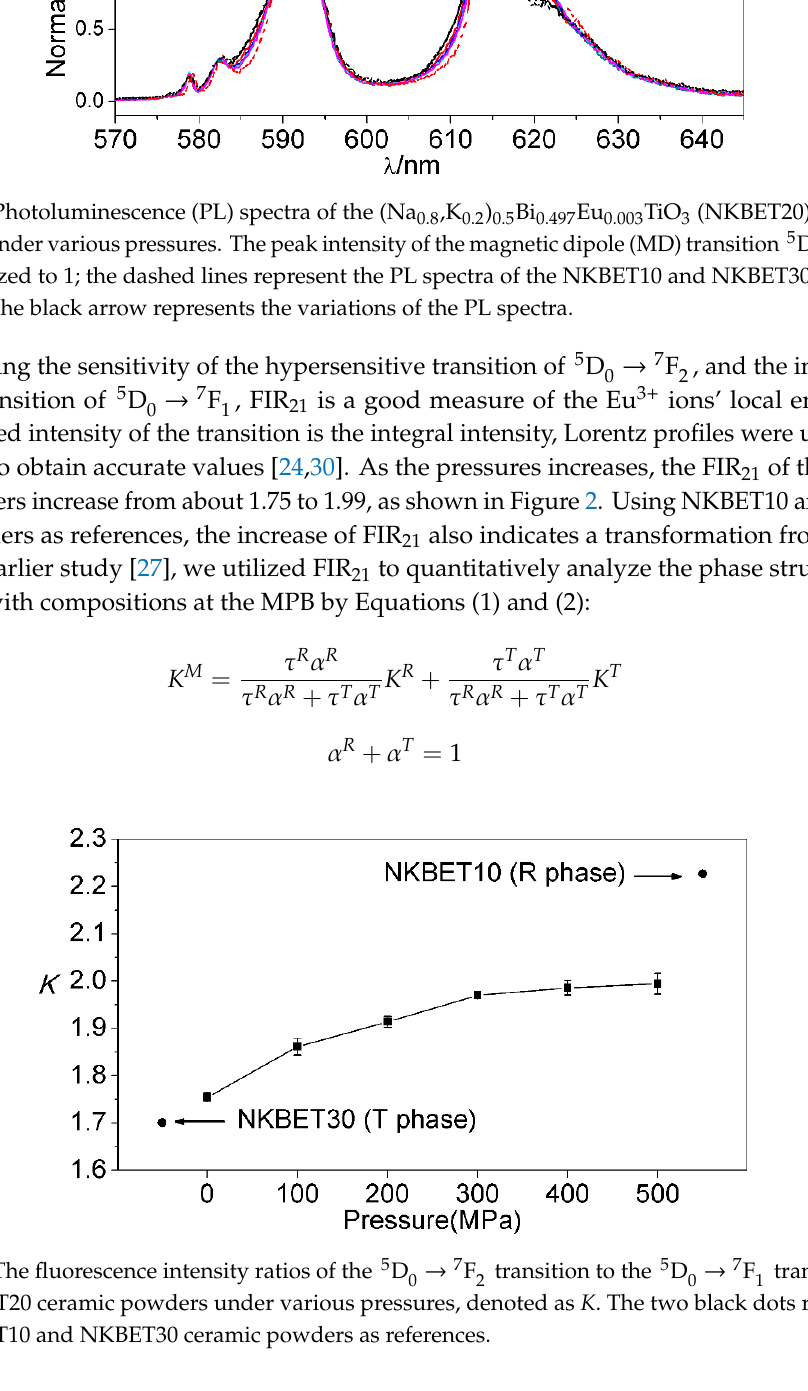
Figure 2. The fluorescence intensity ratios of the 5 D 7 the NKBET20 ceramic powders under various pressures, denoted as K . The two black dots represent the NKBET10 and NKBET30 ceramic powders as references.